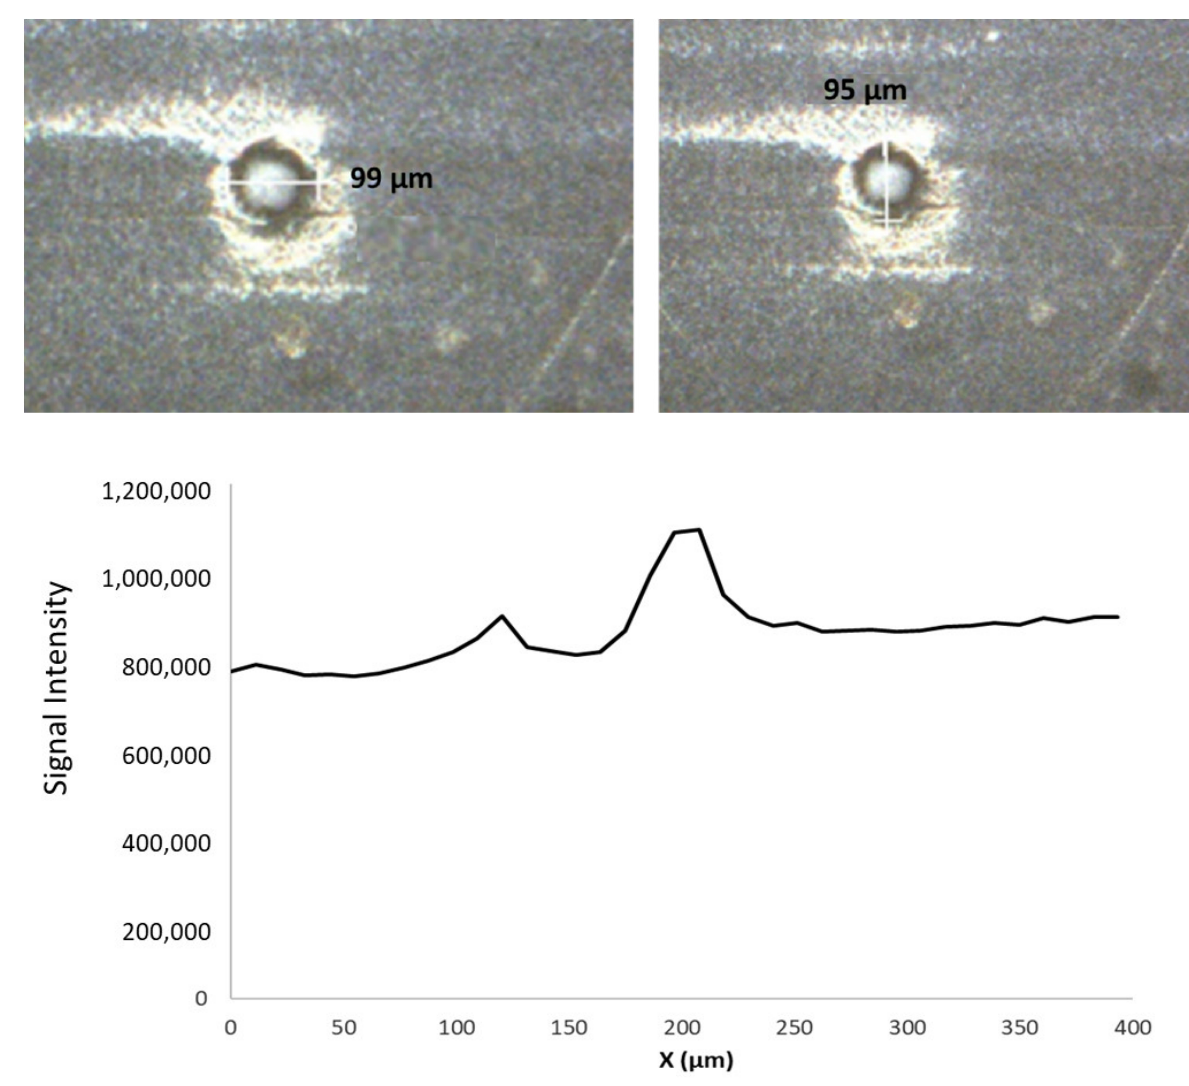
Figure 4. Picture and dimensions (up) and 13 C signal intensities versus the length of the first scan line (down) used to ablate the inclusion # 16 present in film # 2.